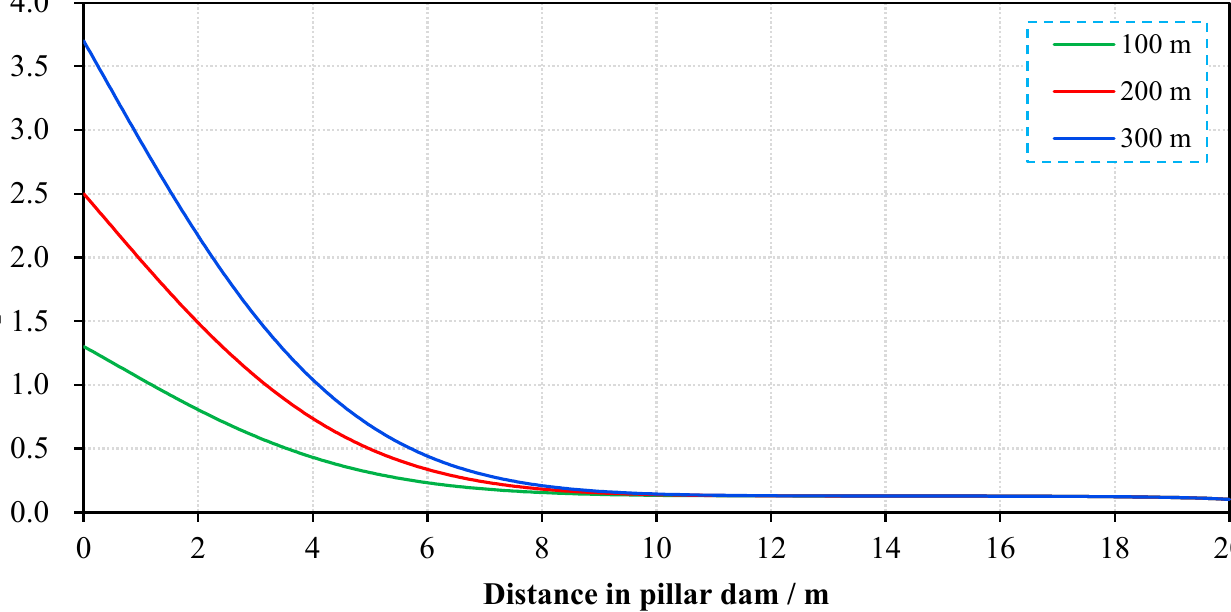
Figure 6. Comparison of pore pressure in the coal pillar dam body under different depths.